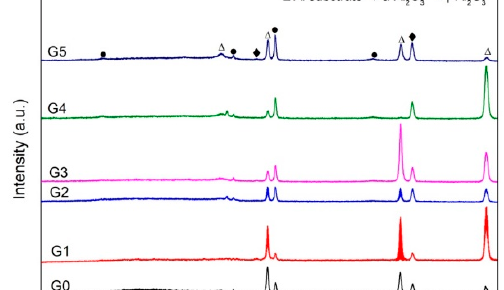
Table 3. Electrochemical parameters obtained from the EIS spectra of PEO coatings.